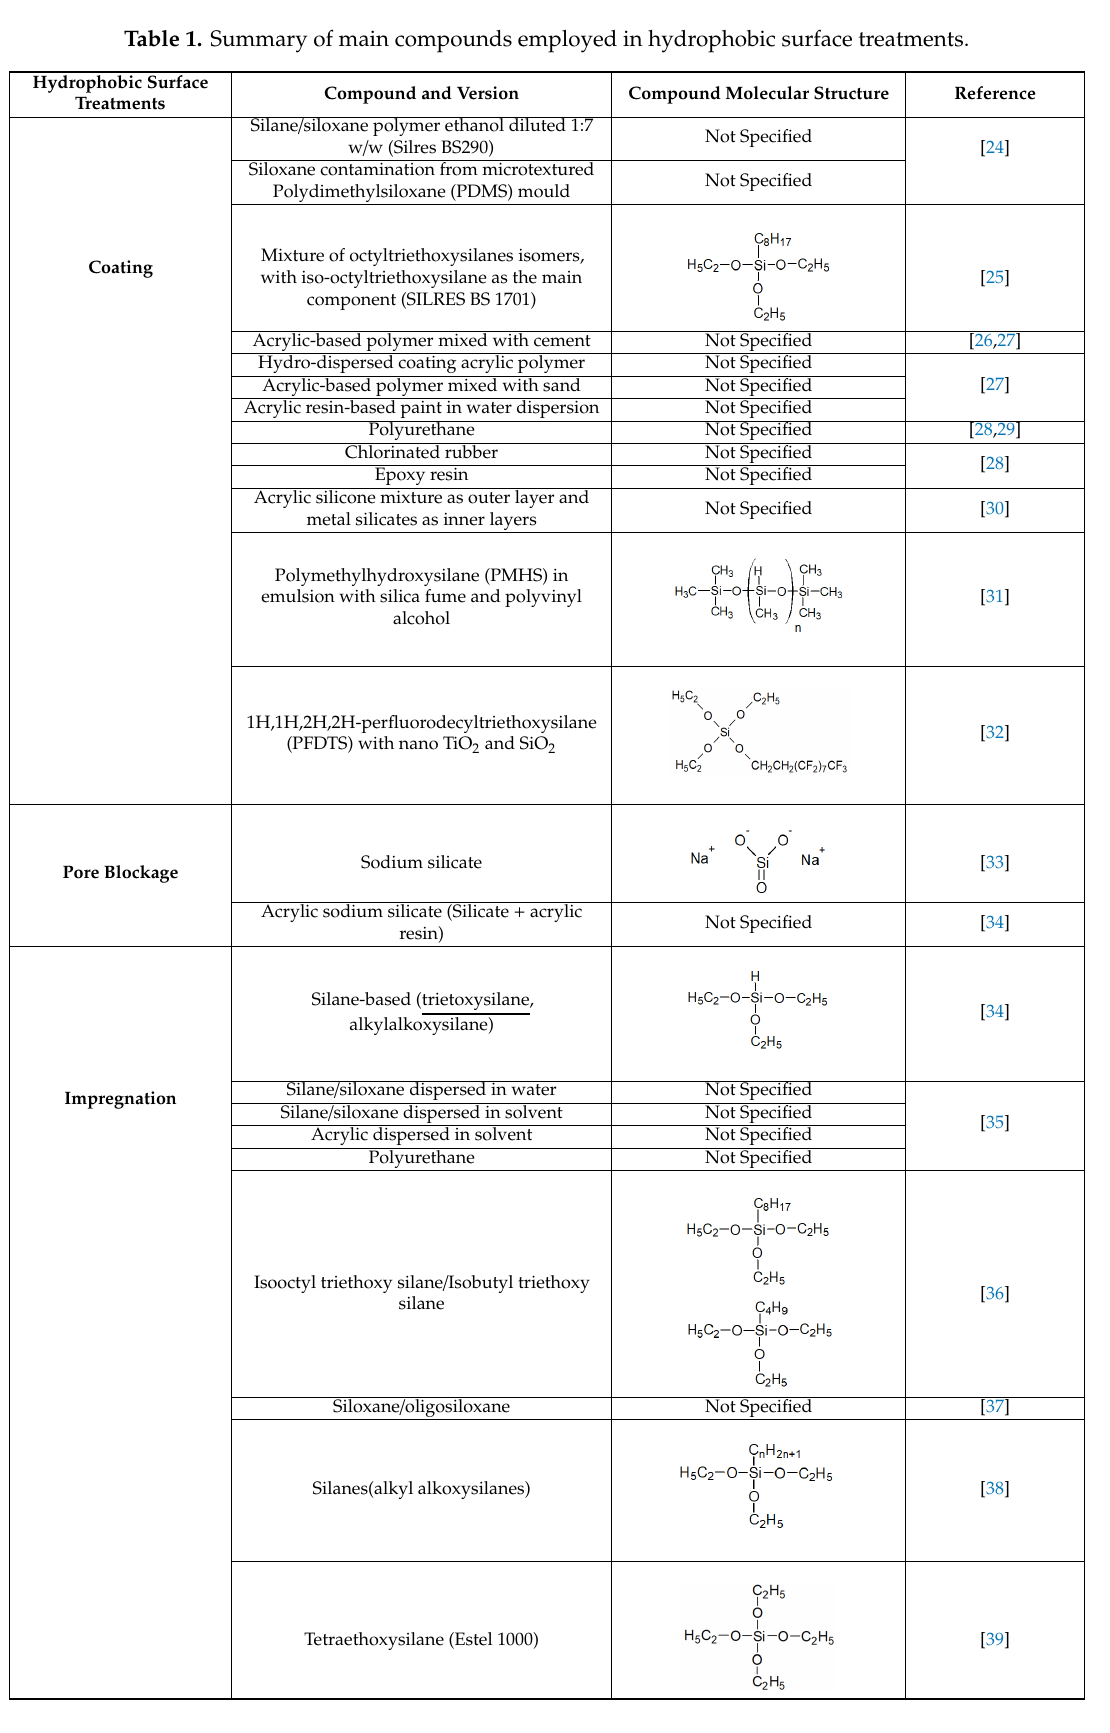
Figure 4. Scheme depicting the different roles of the surface treatment towards water drop ingress and contact angle. Only coating and impregnation (pore liner) result in a hydrophobic effect. 2.1. Coatings Coatings are continuous protective layers, acting as physical barriers, which are cast on the surface of cured concrete, with thickness varying in the range of 0.1–5 mm. The binders can be organic polymers, organic polymers with cement as filler, or hydraulic cement modified with polymer dispersions. When exclusively organic coatings are utilized, the thickness is relatively lower than that of cementitious coatings, generally not exceeding 300 µm. Various kinds of polymers or resins are utilized. The performance of two commercially available polyurethane coatings was evaluated in the study by Vipulanandan and Liu [29] under a sulfuric acid environment (typical of sewer condition) for over five years. In detail, the test results were noticeably different for the two coatings, with one extending the service life of the concrete by 14 times while the other coating did so by 57 times. Furthermore, the coated concrete specimens with pinholes were weaker than those without pinholes and the time to failure was correlated to the type of coating and pinhole size. Almusallam et al. [28] conducted a study to evaluate the durability of concrete coated with five generic types of surface coatings: (i) acrylic coatings, (ii) polymer emulsion coatings, (iii) epoxy resin coatings, (iv) polyurethane coatings, and (v) chlorinated rubber coatings with formulation details not provided; the performance results are presented in Section 6. Cementitious coatings are widely present in the literature. The most used organic polymers in cementitious coatings are acrylate, polyurethane, or epoxy resins (Table 1). The addition of polymers improves the cement paste’s toughness, strength, adhesion, chemical resistance, and impermeability. Other advantages of using polymer-modified cement-based coatings are related to their mitigated shrinkage and considerable breathability [40]. Diamanti et al. [26] tested the permeability of two cementitious coatings modified with acrylic polymers to water, water vapor, and chlorides. The coatings, besides reducing chloride penetration, were shown to not block the evaporation of the water vapor and, consequently, lead to an increase in the concrete durability. The efficiency of four commercial concrete coatings (a polymer-modified cementitious mortar and three elastomeric coatings) against chloride-induced corrosion was discussed by [27],